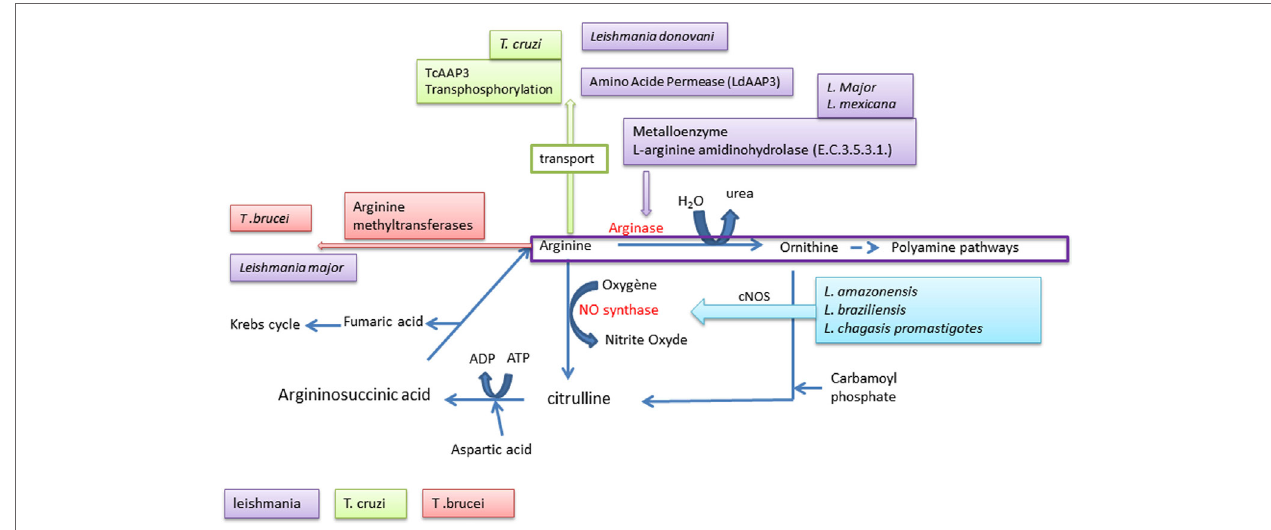
FiGURe 4 | Arginine used by Trypanosomatidae